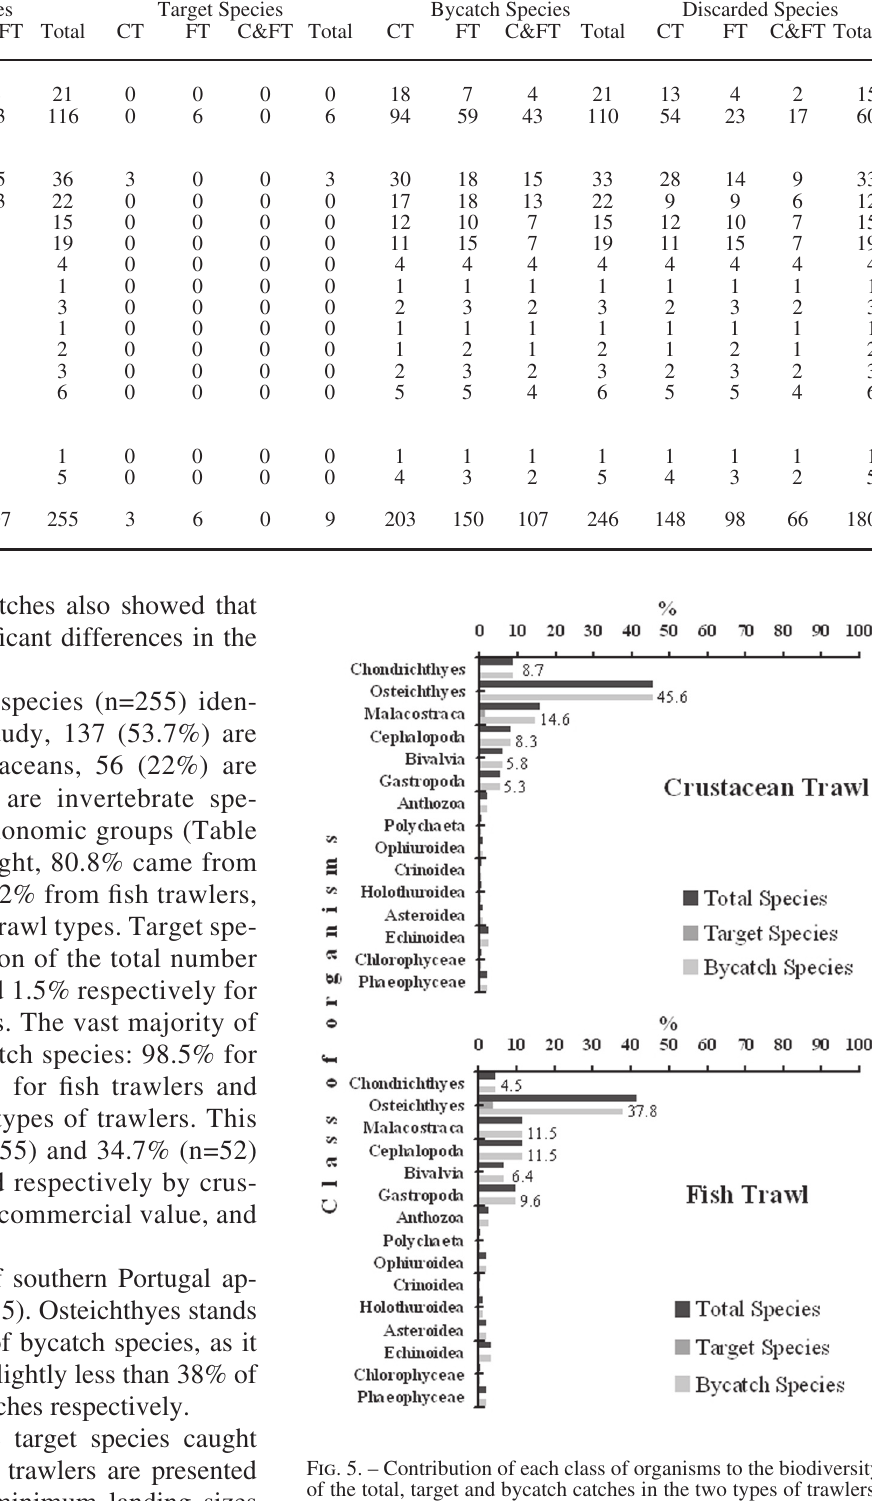
Table 4 – species composition, in number, of the bottom trawl catches off southern Portugal from1999 to 2001. Ct, crustacean trawl; Ft, fish trawl; C&Ft, coincident in both trawls. Class of organisms total species target species vErtEBratEs Chondrichthyes